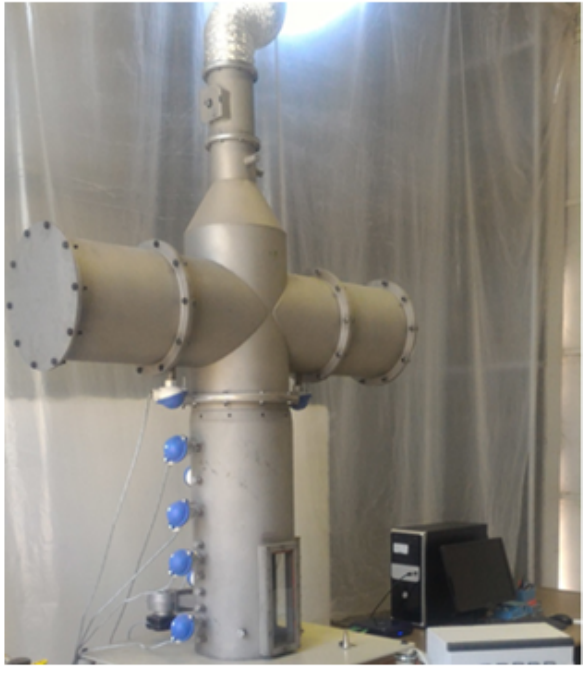
Figure 2: Combustor.